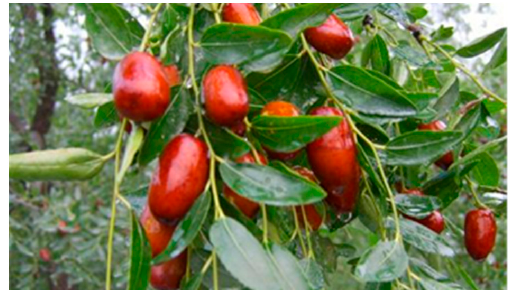
Figure 6. Jujube ( Ziziphus jujuba Mill.).